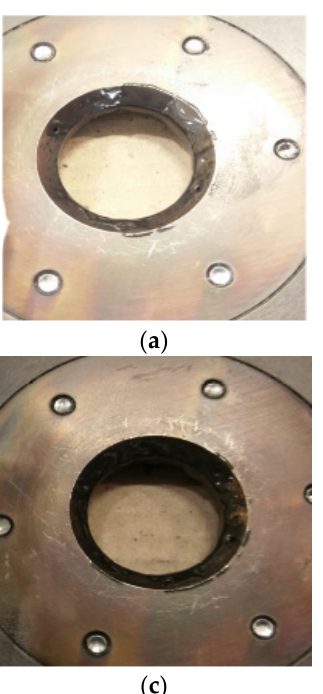
Figure 6. Sample photos of towels above the head for particular test parameters: ( a ) variant 1; ( b )